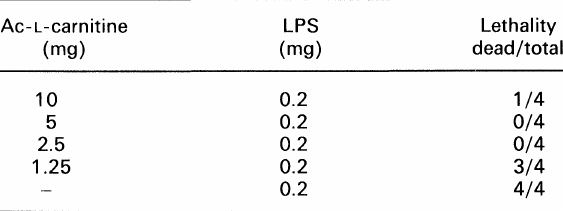
Table 11. Effect of acetyI-L-carnitine on the lethal activity of LPS in P. acnes sensitized mice Ac- L- carn iti ne